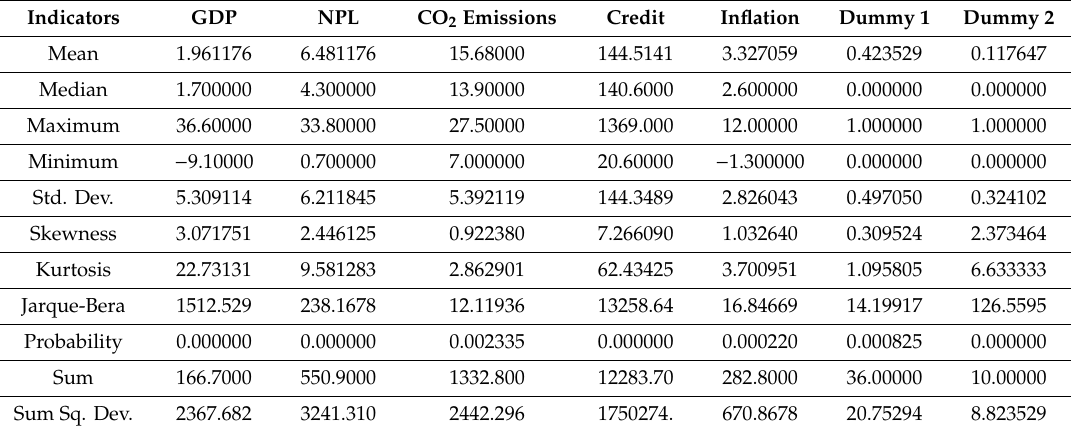
Table 1. Descriptive